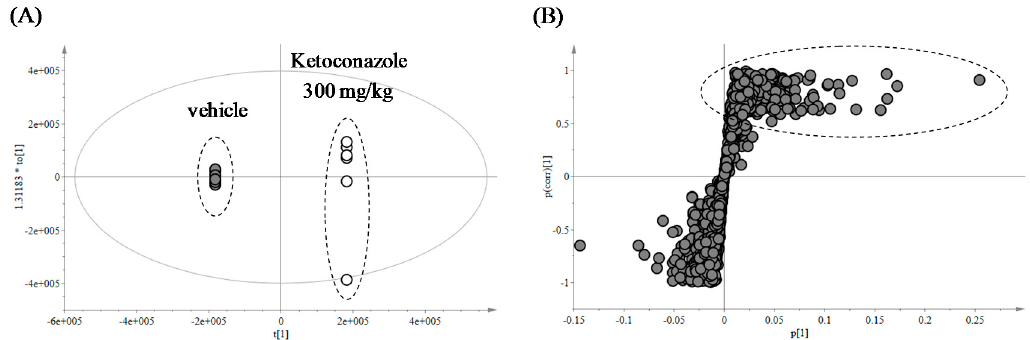
Figure 4. Multivariate data analysis of ketoconazole metabolites in mouse feces. ( A ) Score plot; and ( B ) loading S-plot generated by orthogonal partial least squares discriminant analysis (OPLS-DA). Top-ranking ions were highlighted with dotted ellipse.